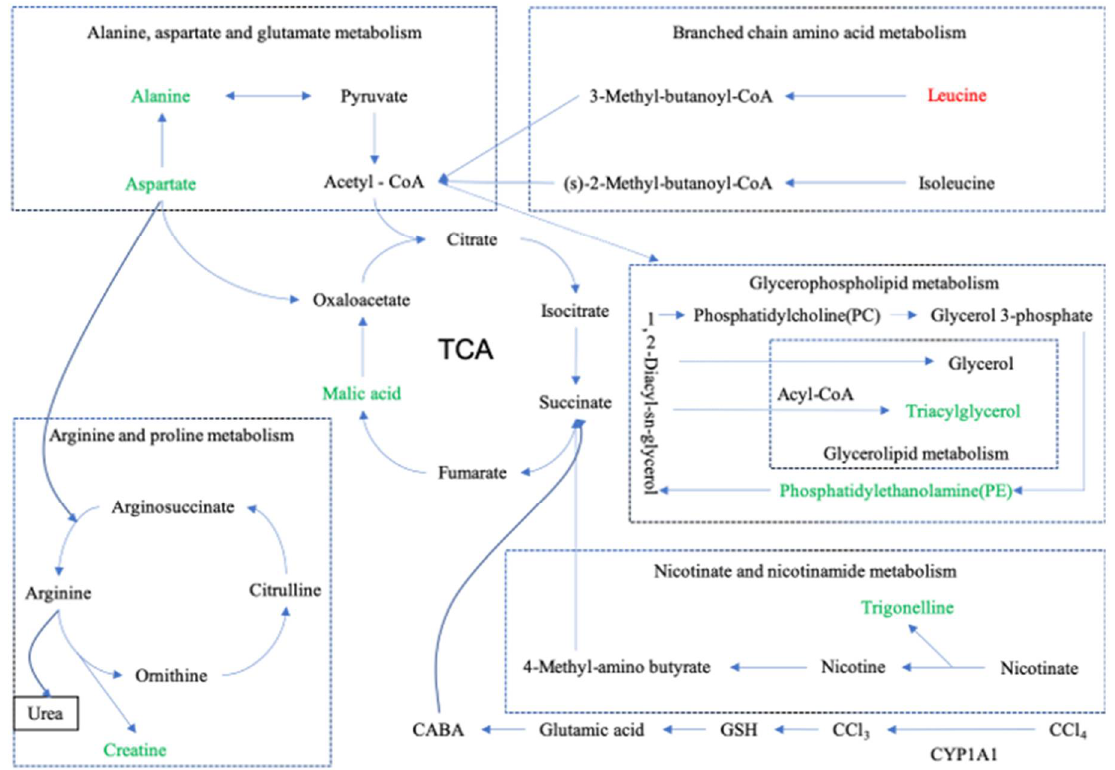
Figure 12. Metabolite pathway. Summary diagram of metabolic pathway relationships. The up-regulated substances are represented in red font, and the down-regulated substances are represented in green font. Dashed lines represent indirect relationships between substances, and solid lines represent direct relationships between substances.